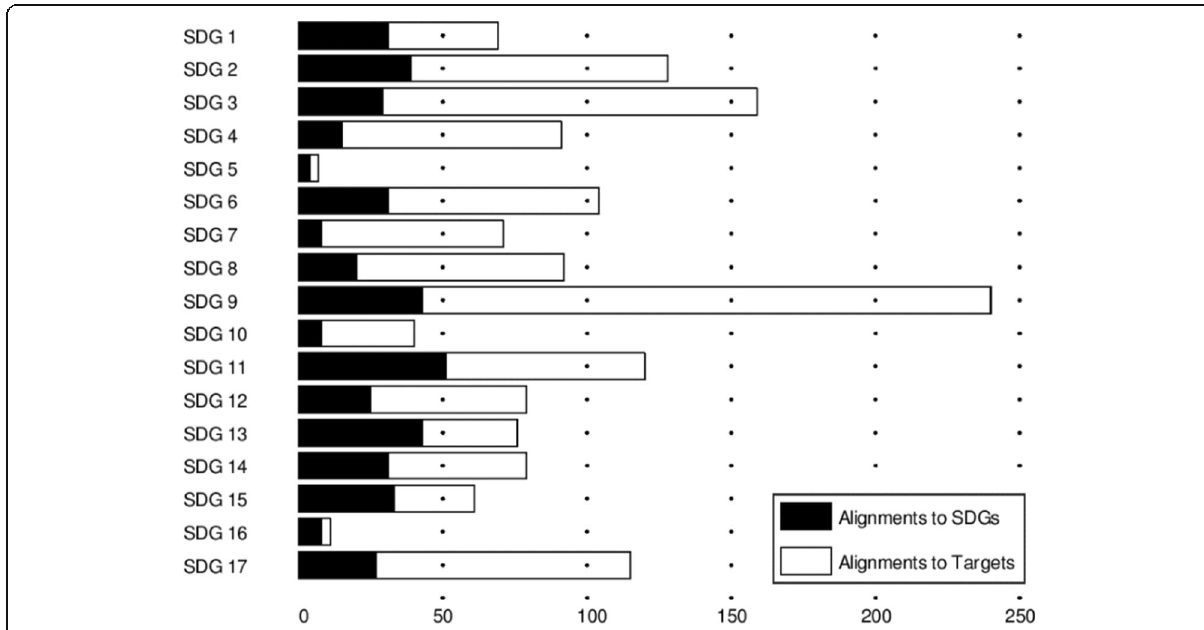
Fig. 5 Number of project alignments per SDG. The graph shows the number of alignments to each SDG (alignments provided at SDG level, not at Target level) and the alignments directly to